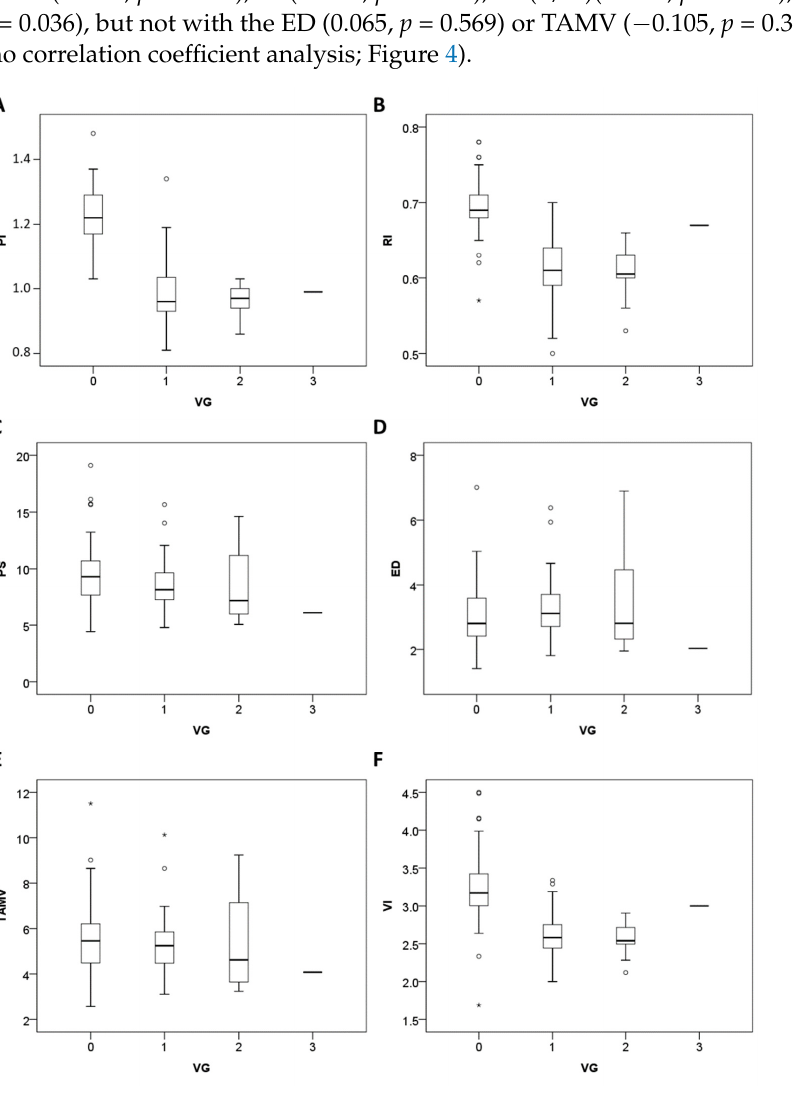
Figure 4. Box plots of the correlations between the vascular grading classification (VG) and six sonographic parameters of the cervix (PI, RI, PS, ED, TAMV, and VI) in the study group ( n = 39) and control group ( n = 40). Negative correlations were observed between the VG and the PI, RI, PS, and VI types ( A , B , C , F ); no correlations were observed for ED or TAMV ( D , E ). *, Extreme outlier; ∘ , Outlier.